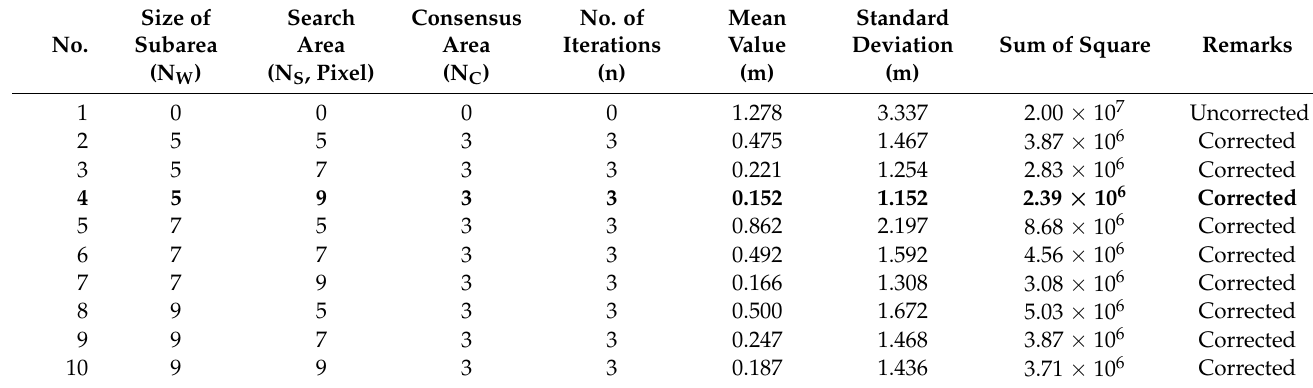
Table 2. Means and the standard deviations of the DoDs for different parameters in the test area. Bold texts indicate the chosen parameters, which have the lowest mean and standard